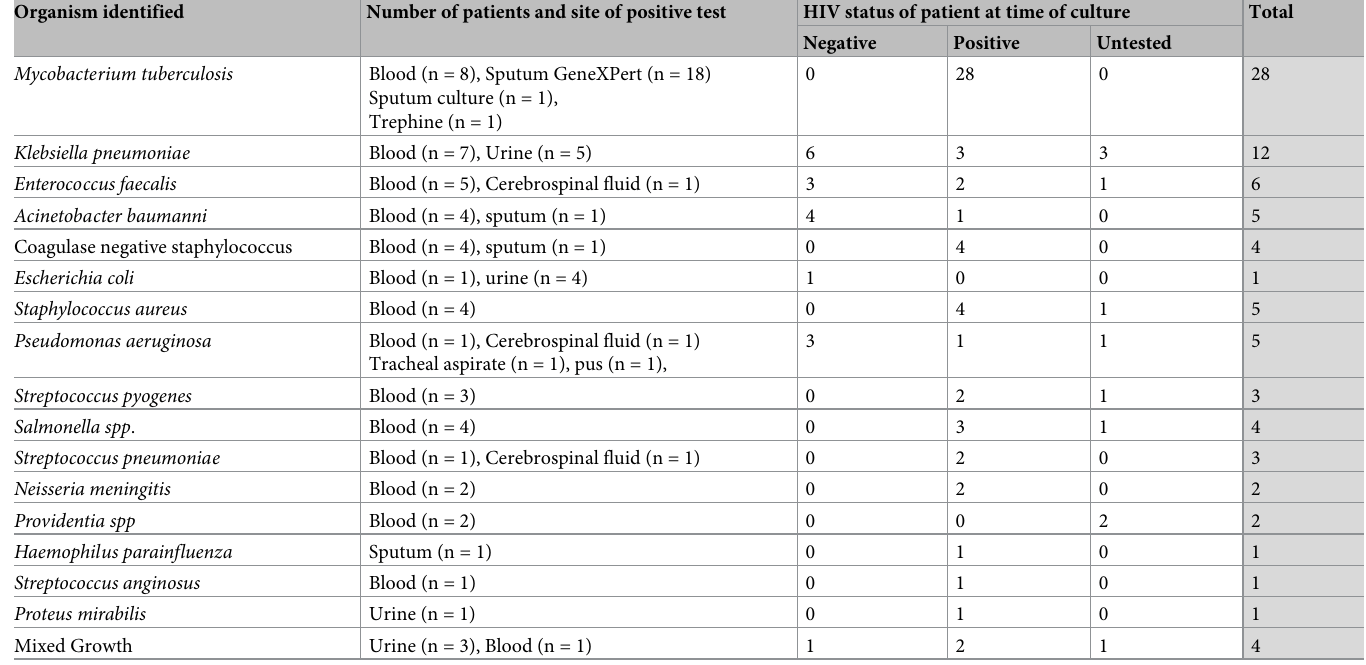
Table 2. Bacteria and mycobacteria identified at time of DIC diagnosis with site of culture and HIV status. Organism identified